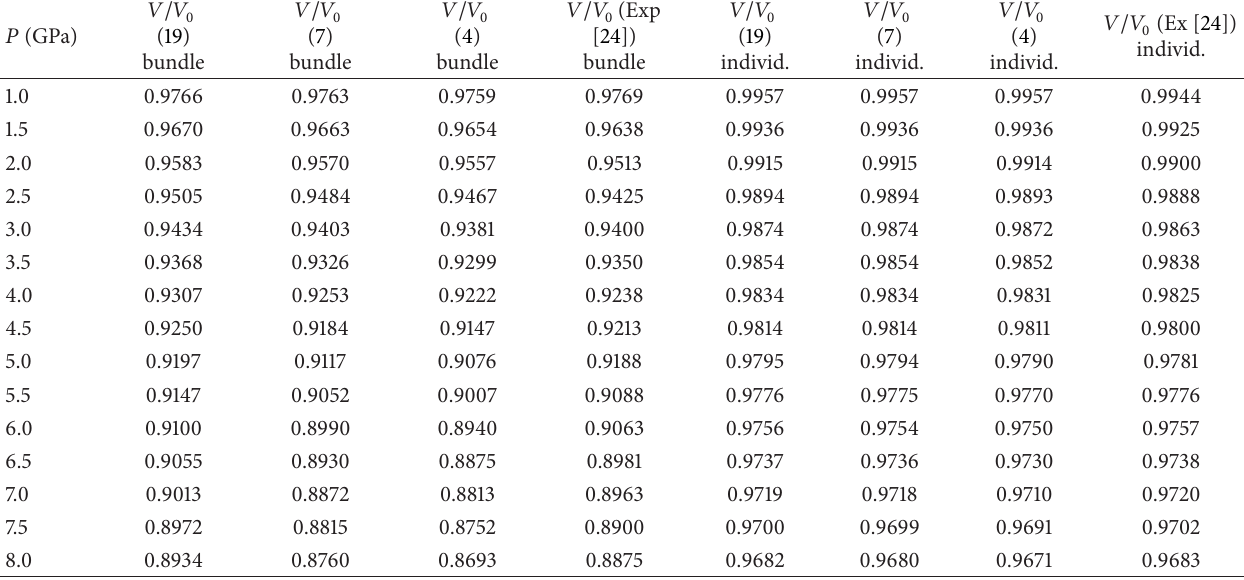
Table 1: Volume compression with pressure for carbon nanotube bundles and individual carbon-nanotubes using different EOSs.